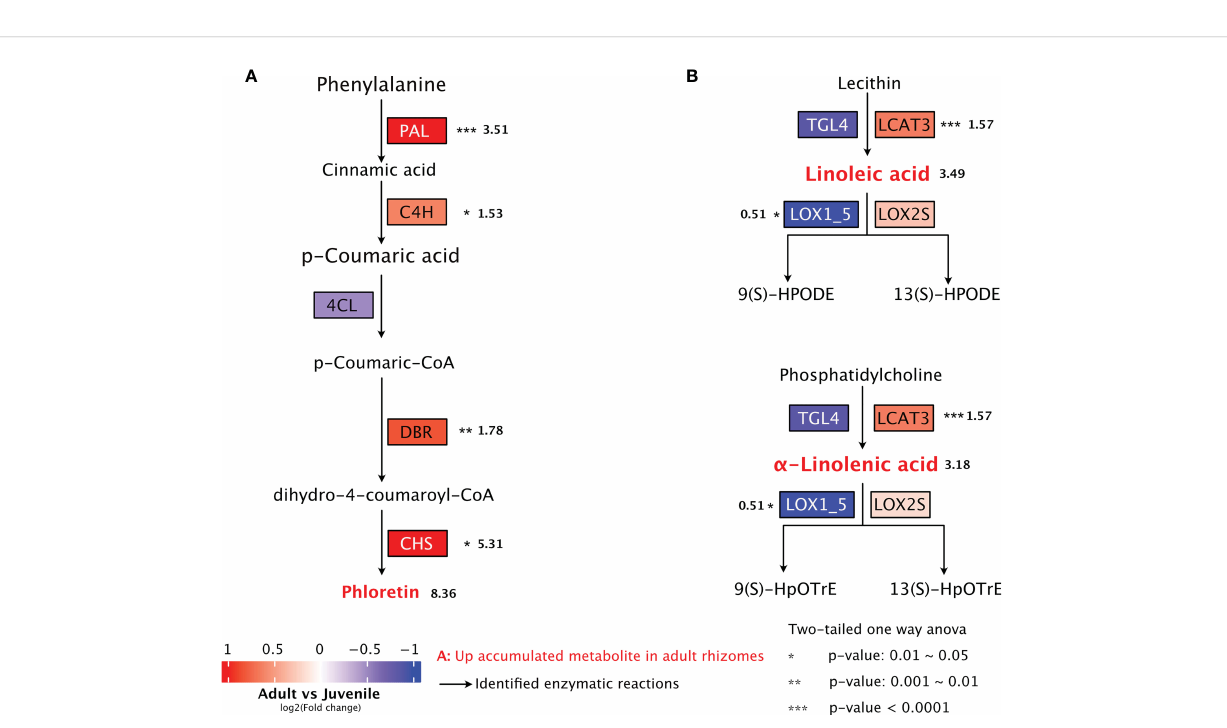
FIGURE 7 Biosynthetic pathways of potential anti-obesity metabolites in rhizomes of P. sibiricum . (A) Biosynthesis of phloretin. (B) Biosynthesis and metabolism of linoleic acid and a -linolenic acid. The metabolites with higher accumulation in adult rhizomes are colored in red. Asterisks indicate signi fi cant difference in the gene expression between juvenile and adult rhizomes. Numbers (in bold) next to asterisks or metabolites are fold changes of the expression levels of indicated genes (adult/juvenile) or fold changes of peak areas of metabolites colored in red (adult/juvenile). The arrows represent the enzymatic reactions.